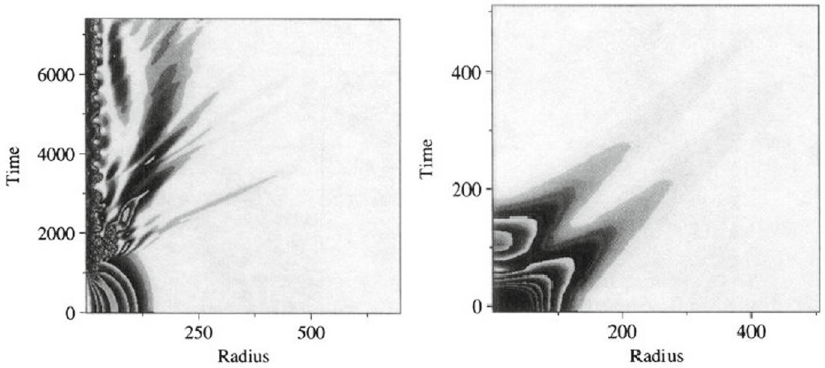
Fig. 15 The evolution of r 2 ρ (where ρ is the energy density of the complex scalar field) with massive field (left) and massless (right). In the massive case, much of the scalar field collapses and a perturbed boson star is formed at the center, settling down by gravitational cooling. In the massless case, the scalar field bounces through the origin and then disperses without forming any compact object. Reprinted with permission from Seidel and Suen (1994); copyright by